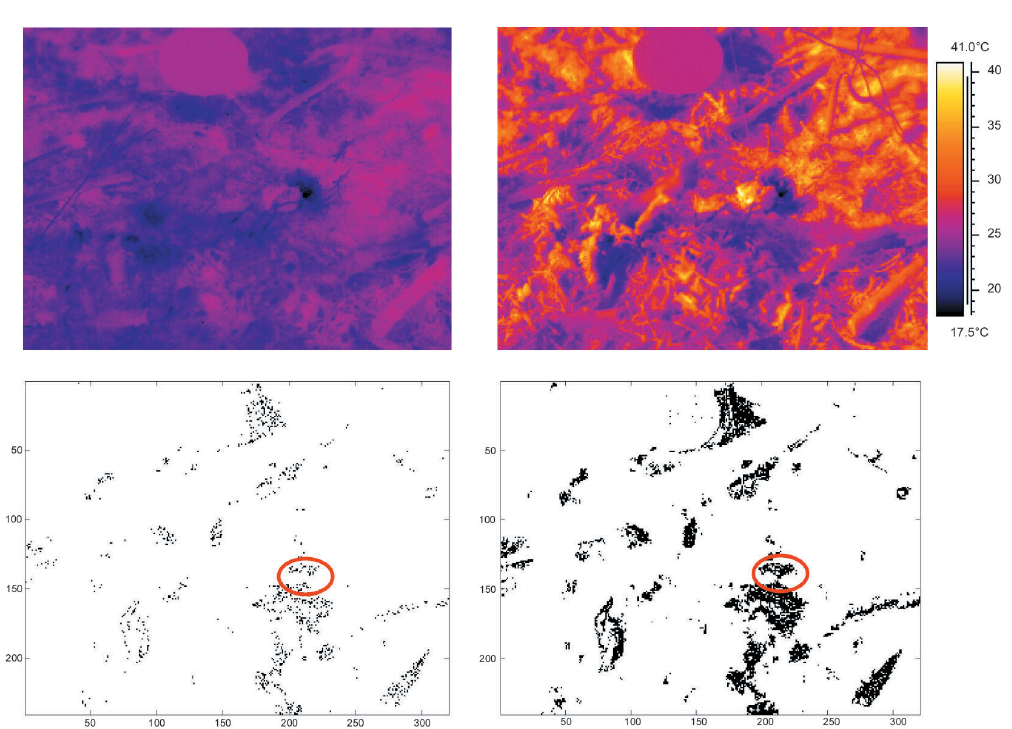
Fig. 11. Thermal images and temperature difference ∆ T of mofette location in the forest of Podhorny Vrch, Czech Republic, recorded at two different times on 15th June 2003, at 18:18 h (scene shaded, top left ) and at 18:26 h (scene sunlit, top right ). Thresholds are set to ∆ T < 0.1 K ( bottom left ) < 0.5 K ( bottom right ). Red oval marks identified gas outlet.